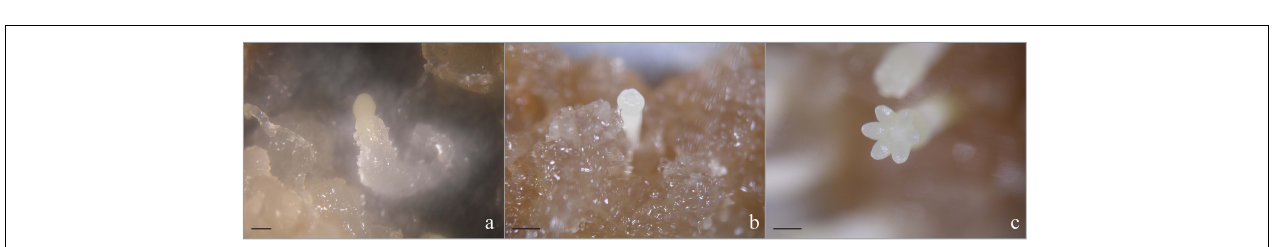
FIGURE 6 | Number of mature cotyledonary somatic embryos per ml of packed cell volume (PCV) obtained from solid maturation medium after culturing for 6–7 weeks. (A) In suspension culture, embryogenic suspensor mass (ESM) was treated at different temperatures for 12 h in the period of exponential growth of the culture cycle. (B) Cells were cultured on suspension medium without PGRs and then transferred to solid maturation medium with different concentrations of PEG, 45.2 µ M/L ABA and 14.5 µ M/L GA. The different lowercase letters indicate significant differences ( P < 0.01) between treatments based on Duncan’s test. Data represent the mean ± SD of three replicates.